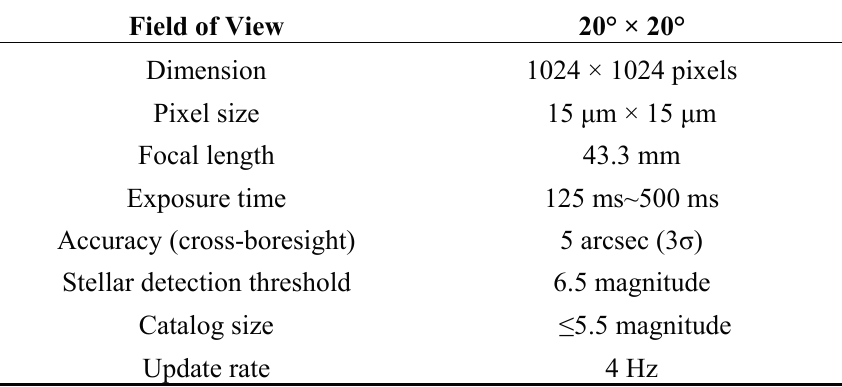
Table 1. Key Parameters of ZY-3’s APS Star